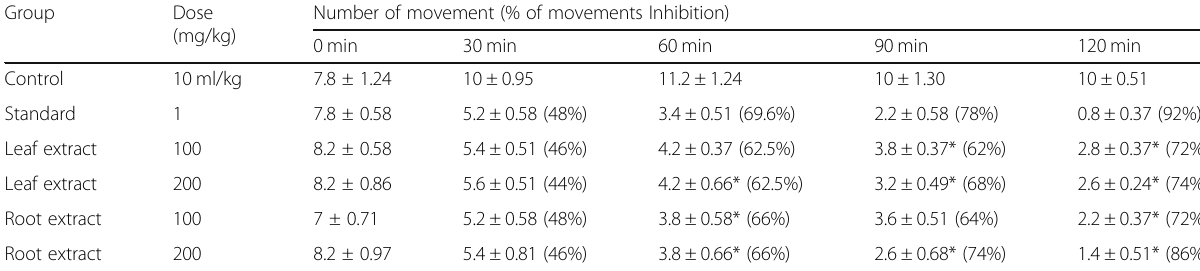
Table 2 CNS depressant activity test result of C. turgida extracts by hole cross method Group